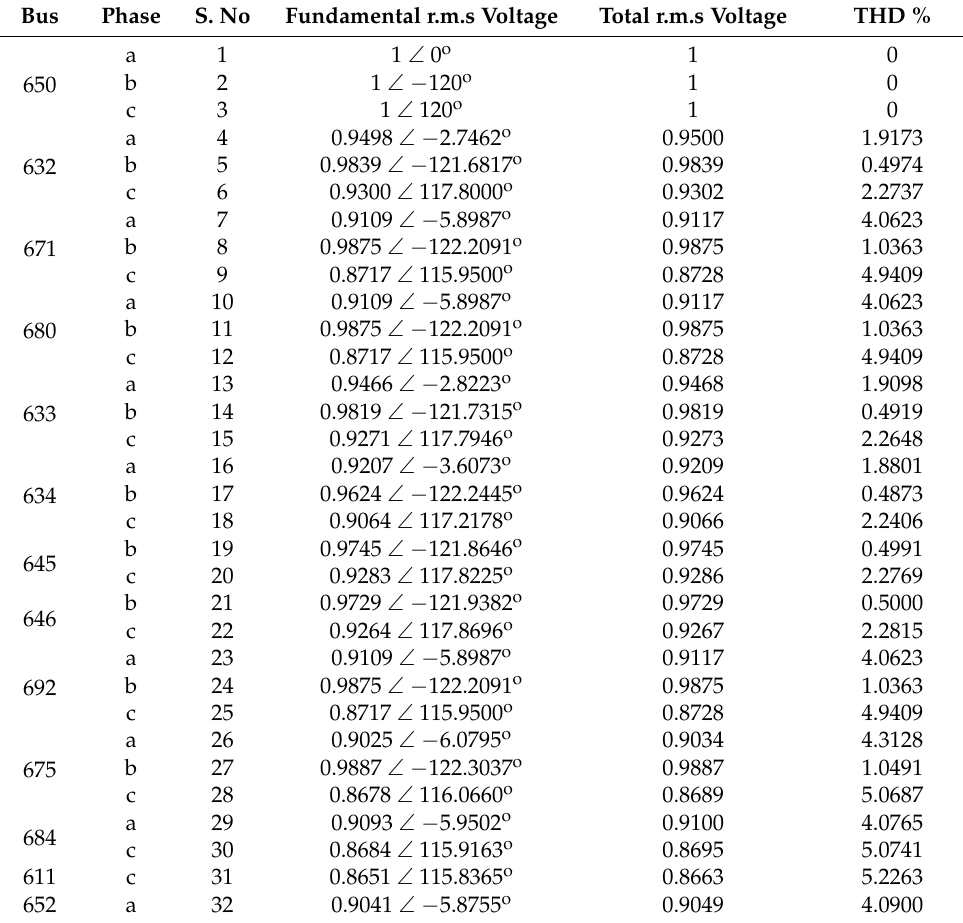
Table 7. Fundamental r.m.s voltage, total r.m.s voltages, and THD % in IEEE − 13 bus URDN.